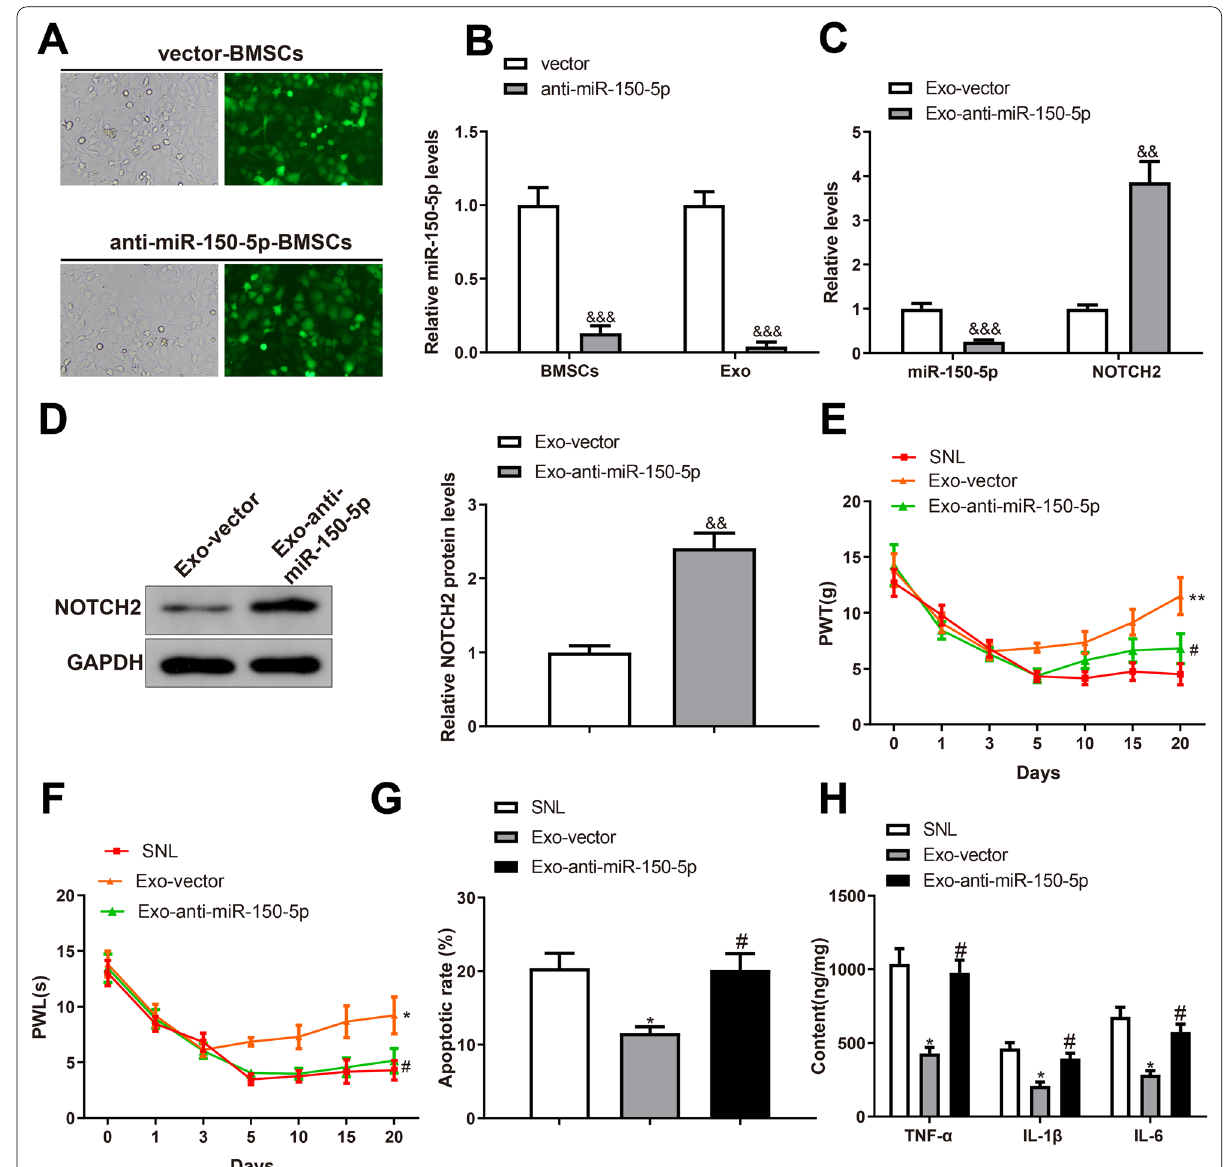
Fig. 7 Inhibition of miR-150-5p in BMSC-exosomes offsets the therapeutic effects of BMSC-exosomes on mechanical allodynia. A The transfection efficiency was observed under a fluorescence microscope; B RT-qPCR was used to detect the expression of miR-150-5p in BMSCs and BMSC-exosomes. RT-qPCR C and western blotting D were used to detect the expression of miR-150-5p and NOTCH2 in the SDH of SNL rats; Hind paw PWT E and PWL F of SNL rats were measured on days 0, 1, 3, 5, 10, 15, and 20 after surgery; G TUNEL staining revealed the apoptosis in the SDH; H ELISA detected the expression levels of TNF-α, IL-1β and IL-6 in the SDH. Data were shown as mean the vector or Exo-vector group. BMSC bone marrow mesenchymal stem cell, SNL spinal nerve ligation, SDH spinal dorsal horn, PWT paw